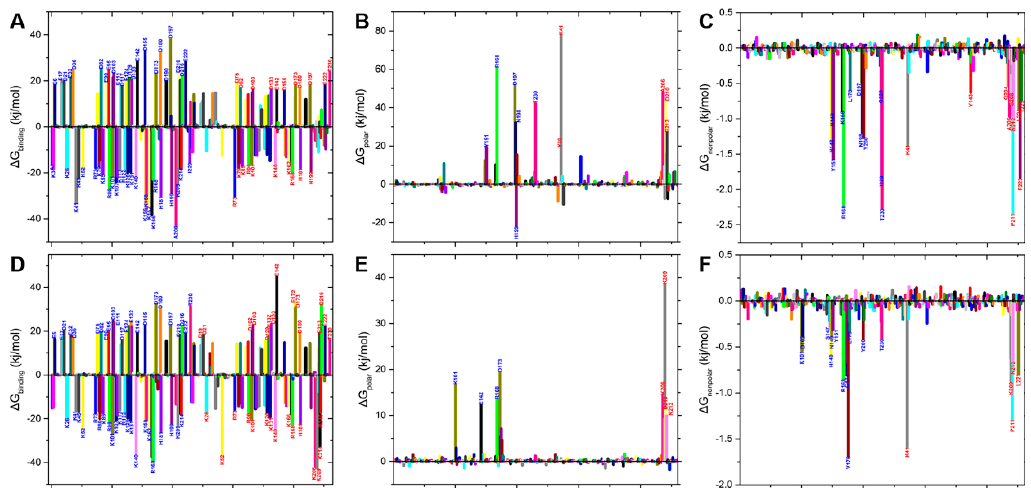
Figure 6. Per-residue energy contribution plots. Binding free energy contribution of each residue to the interactions between GFP monomers ( A ) and GFP-A206K monomers ( D ). Polar binding energy contribution of each residue to the interactions between GFP monomers ( B ) and GFP-A206K monomers ( E ). Nonpolar binding energy contribution of each residue to the interactions between GFP monomers ( C ) and GFP-A206K monomers ( F ). The residues with the most favorable (< − 10 kJ/mol) and unfavorable (> 10 kJ/mol) contributions are